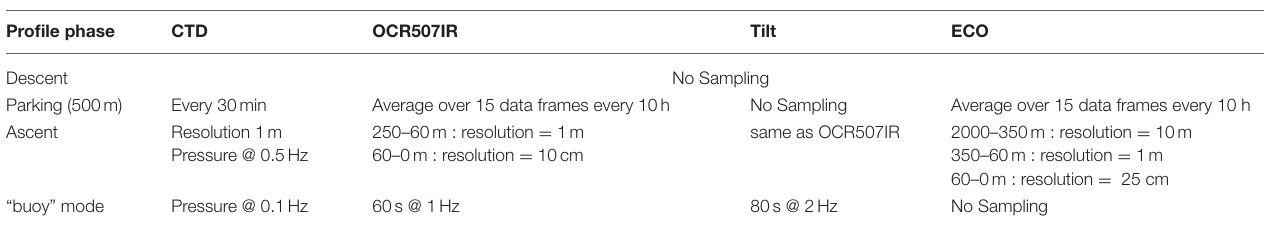
TABLE 2 | Subsampling